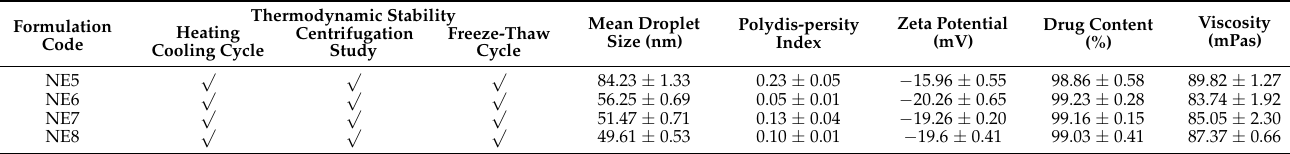
Table 2. Characterization of selected CUR-loaded NE for thermodynamic stability, droplet size distribution, zeta potential, % drug content, and